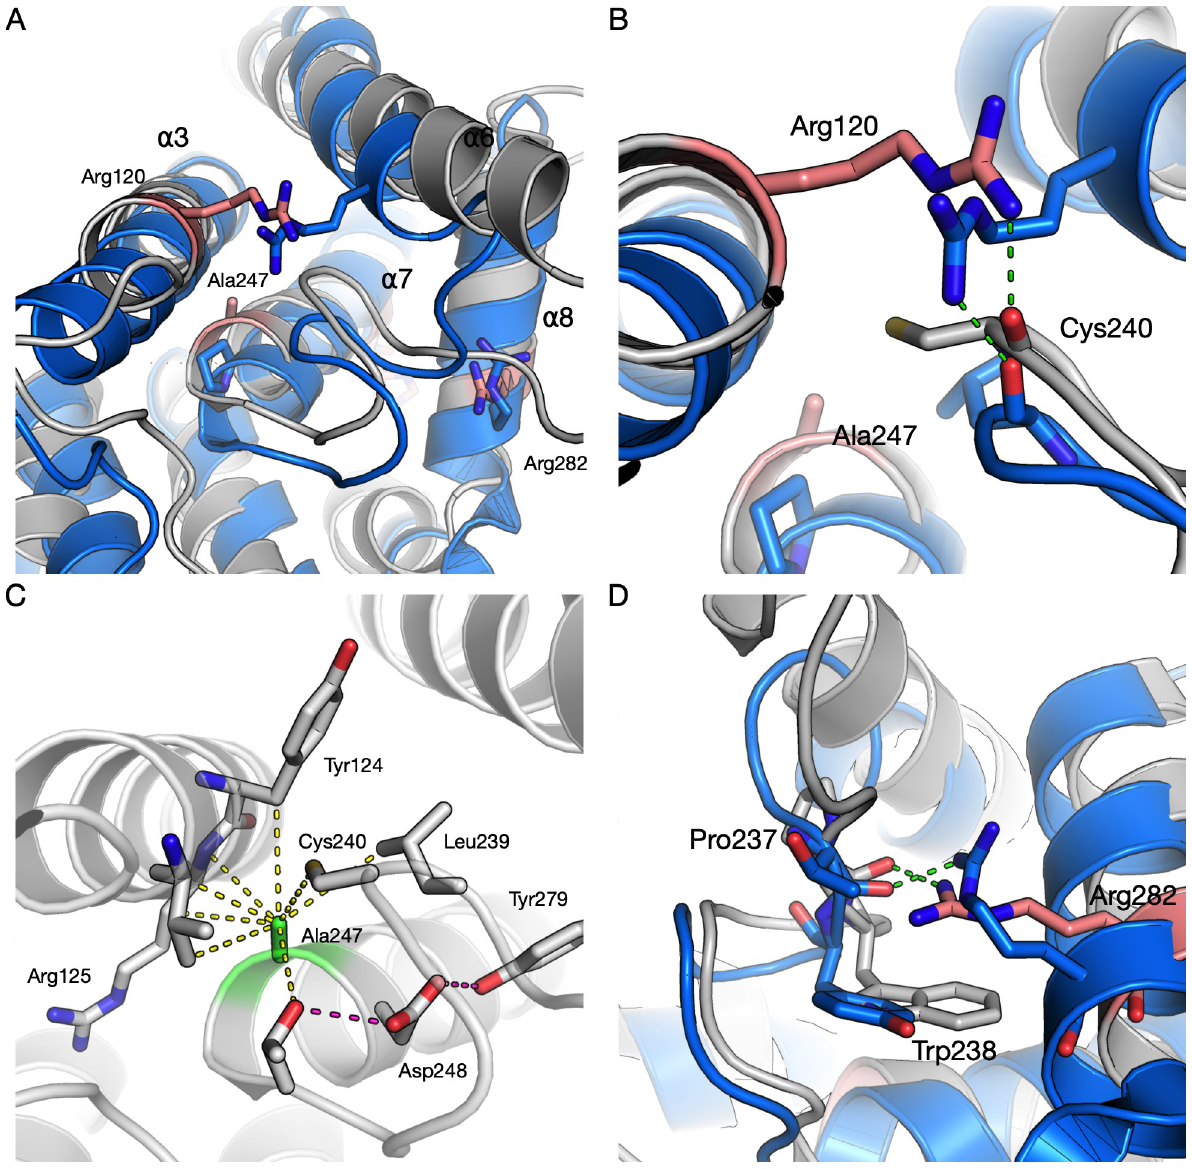
Fig 10. Comparisons of the studied mutations to a canonical GST from S. japonicum. GDAP1 is in gray and GST in blue. A. Overall view of the GDAP1-GST superposition, with the CMT mutation sites crystallised here highlighted in pink. B. Arg120 (pink) in GDAP1 and the corresponding interaction in GST, made by an Arg from a nearby helix. C. Tight packing of Ala247 (green) in the GDAP1 structure; Ala at this position is highly conserved across the whole GST family. Note Tyr124, which was highlighted in the KL divergence analysis, making direct van der Waals contact with Ala247. D. The interactions of Arg282 (pink) towards the α 6- α 7 loop and Trp238 are conserved in GST. https://doi.org/10.1371/journal.pone.0284532.g010 protein structure stability. One of the residues in GDAP1 highlighted by the KL divergence analysis, Tyr124, closely interacts with Ala247, indicating a GDAP1-specific arrangement at this site. Additionally, one of the most conserved GDAP1 residues, Asp248, is central in a hydrogen bonding network linking the conserved CMT target Tyr279 into the picture ( Fig 10C ). GST has an Arg corresponding to Arg282, and this residue is highly conserved. Arg282 in GDAP1 interacts directly with the backbone of the α 6- α 7 loop, and a similar interaction is